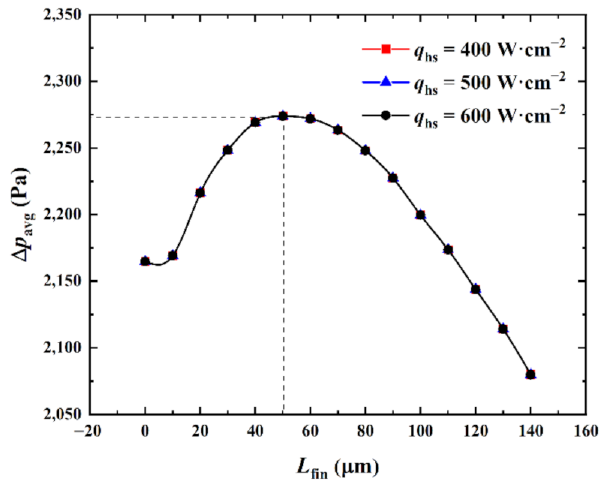
Figure 11. Effect of q hs on ∆ p avg versus L fin